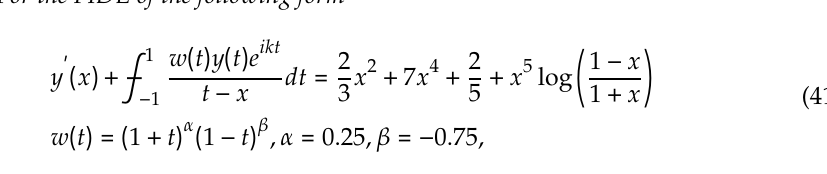
Table 7 for N = 10 and Figure 5 for N = 15 represent the absolute error. Table 7. Absolute error for N =